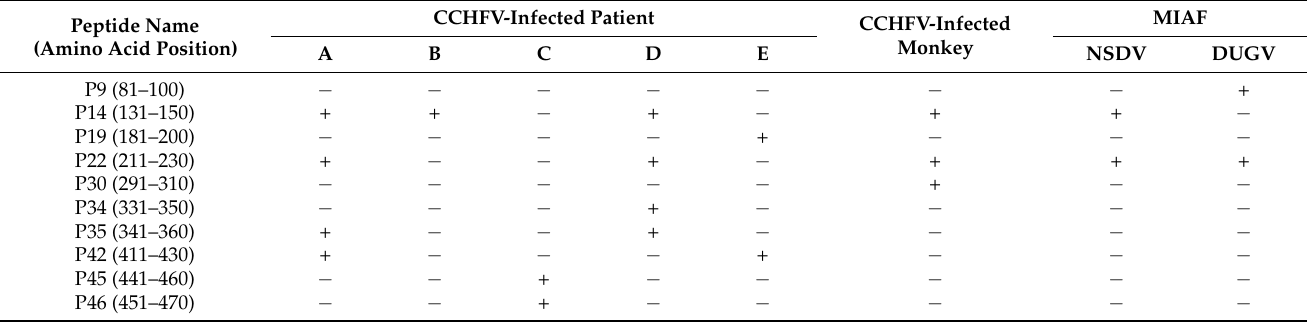
Table 3. Synthetic peptides to which anti-NP antibodies in the sera and MIAFs